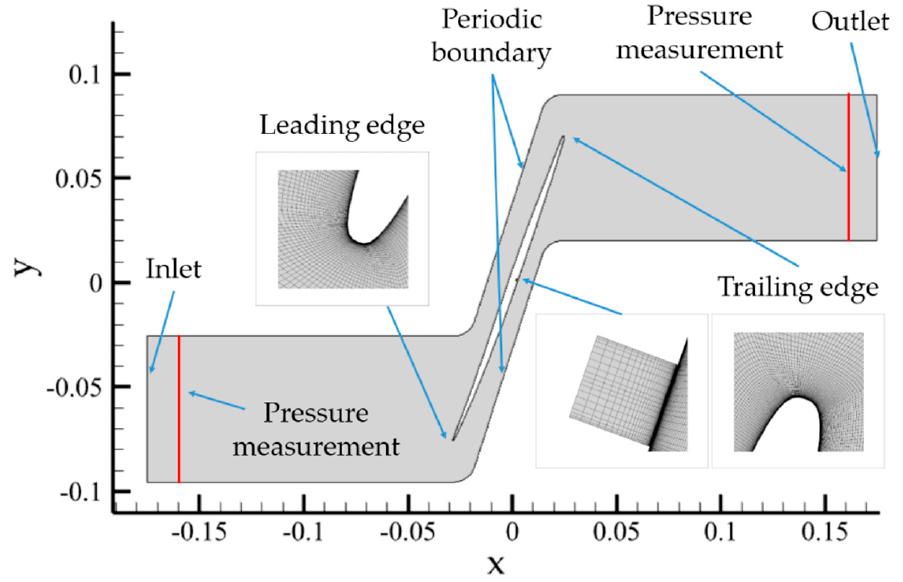
Figure 1. C omputational domain and grid of cascade. Figure 1. Computational domain and grid of cascade. The control scheme of the air jet on the “shock-in-type” supersonic cascade is shown in Figure 2. The jet slot was arranged on the pressure side of the blade located upstream of the trailing-edge (TE) shock. The location of the air jet ∆ l is defined as the distance between the jet slot and the front foot of the λ shock wave on the pressure side. The ∆ l is dimensionless as the ratio of actual distance to the local boundary layer thickness. The jet angle α is defined as the angle between the direction of the air jet and the chordal direction of the blade. The strength of the jet is measured by the mass-weighted average total pressure at the outlet of the jet